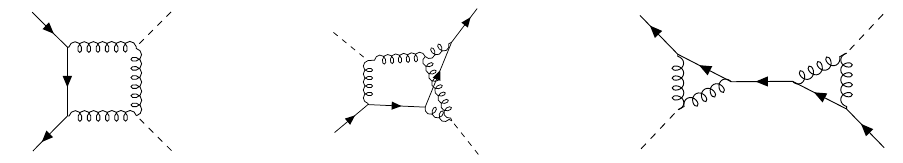
Figure 2. Sample diagrams for q ¯ q → φφ at NLO (first diagram) and NNLO which belong to class-B and are proportional to C 2 H